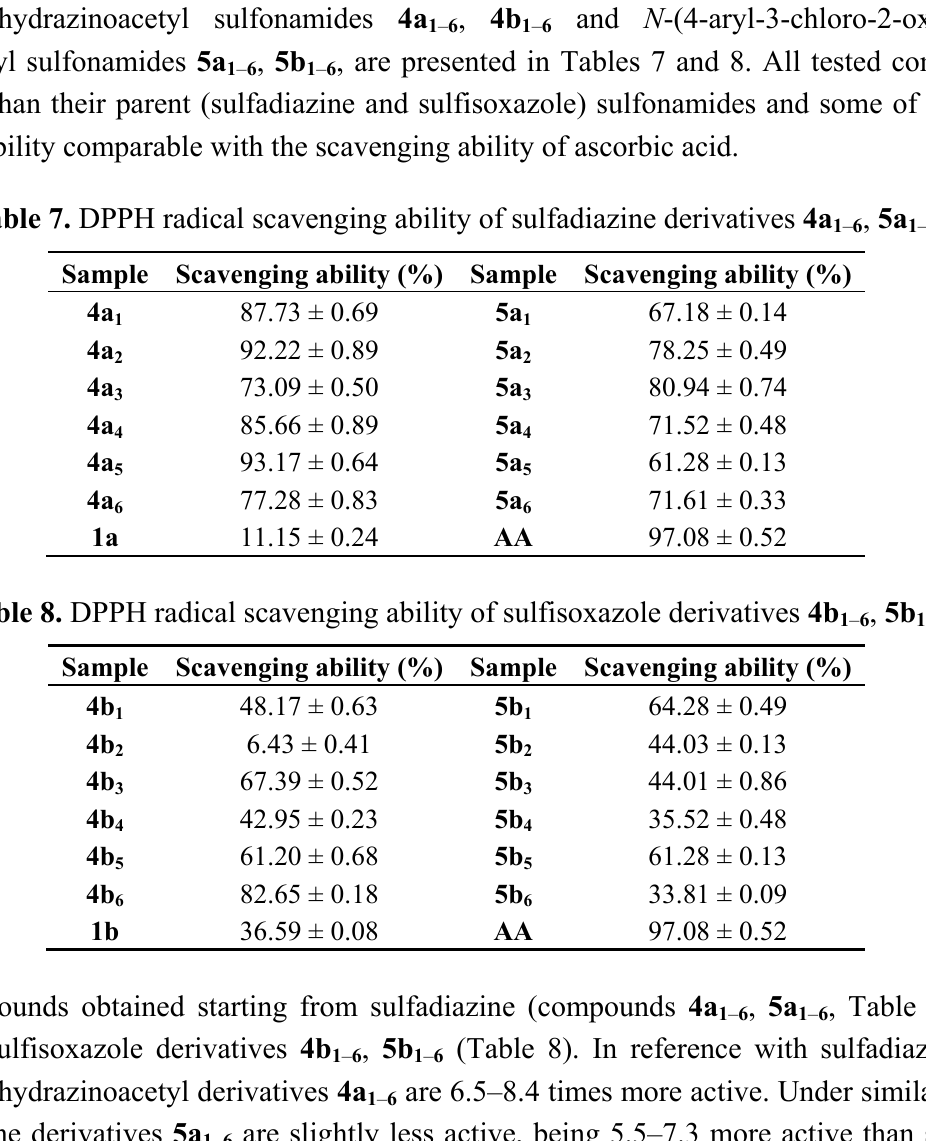
Table 7. DPPH radical scavenging ability of sulfadiazine derivatives 4a